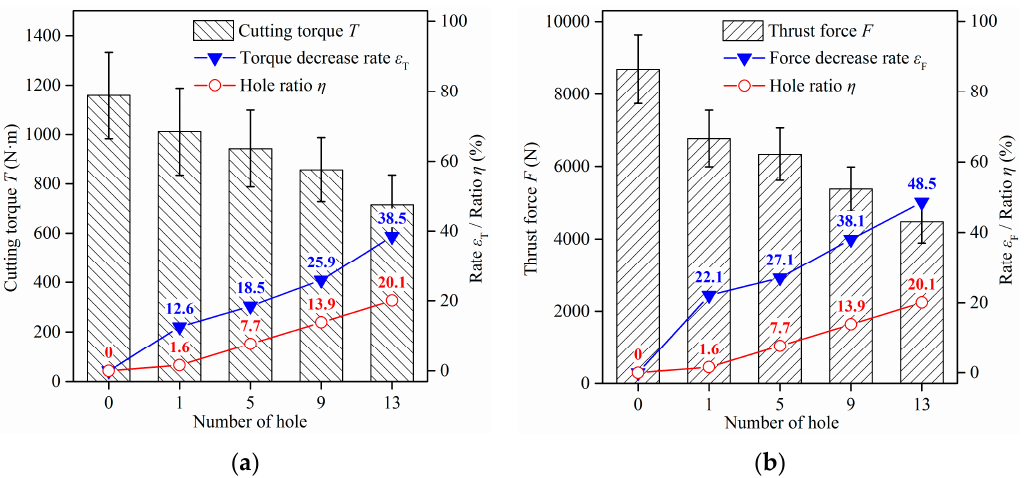
Figure 8. Effect of hole number on ( a ) cutting torque and ( b ) thrust force.